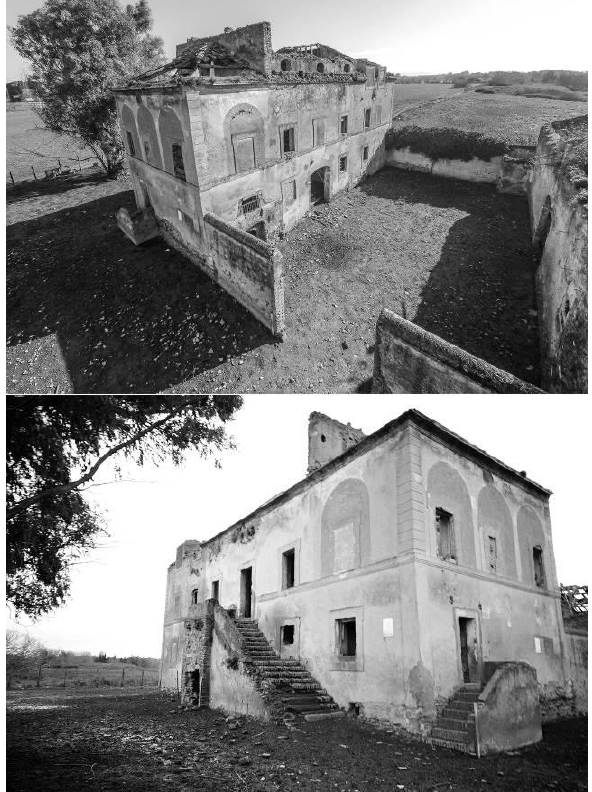
Figure 5. Two views of the Vigne Viola